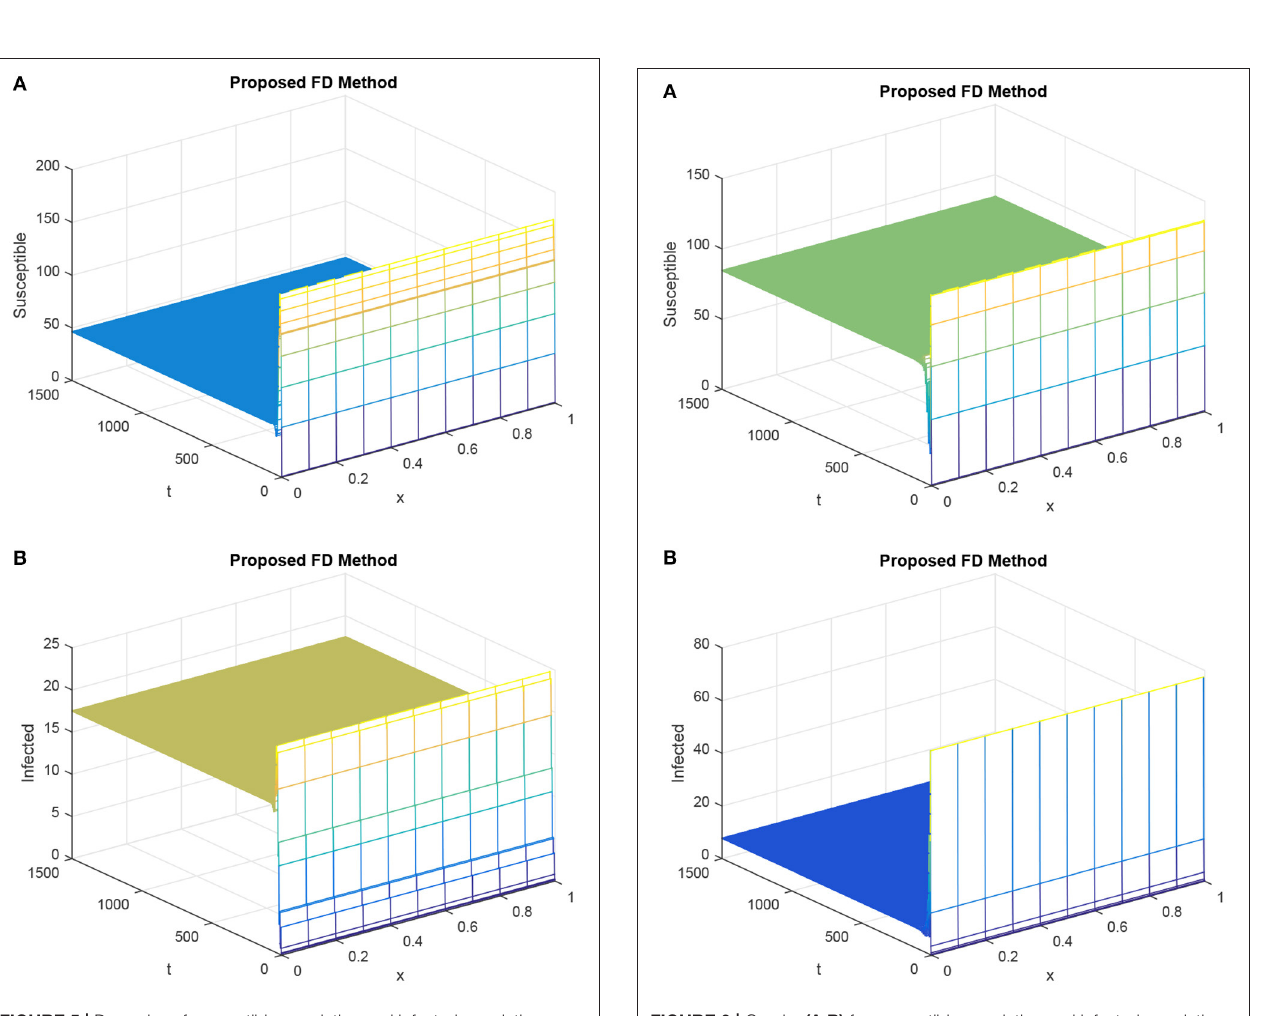
FIGURE 6 | Graphs (A,B) for susceptible population and infected population considering the proposed method, given h = 0.1 and R 1 = R 2 = 0.15, τ = 9. (A) Mesh graph of S . (B) Mesh graph of I